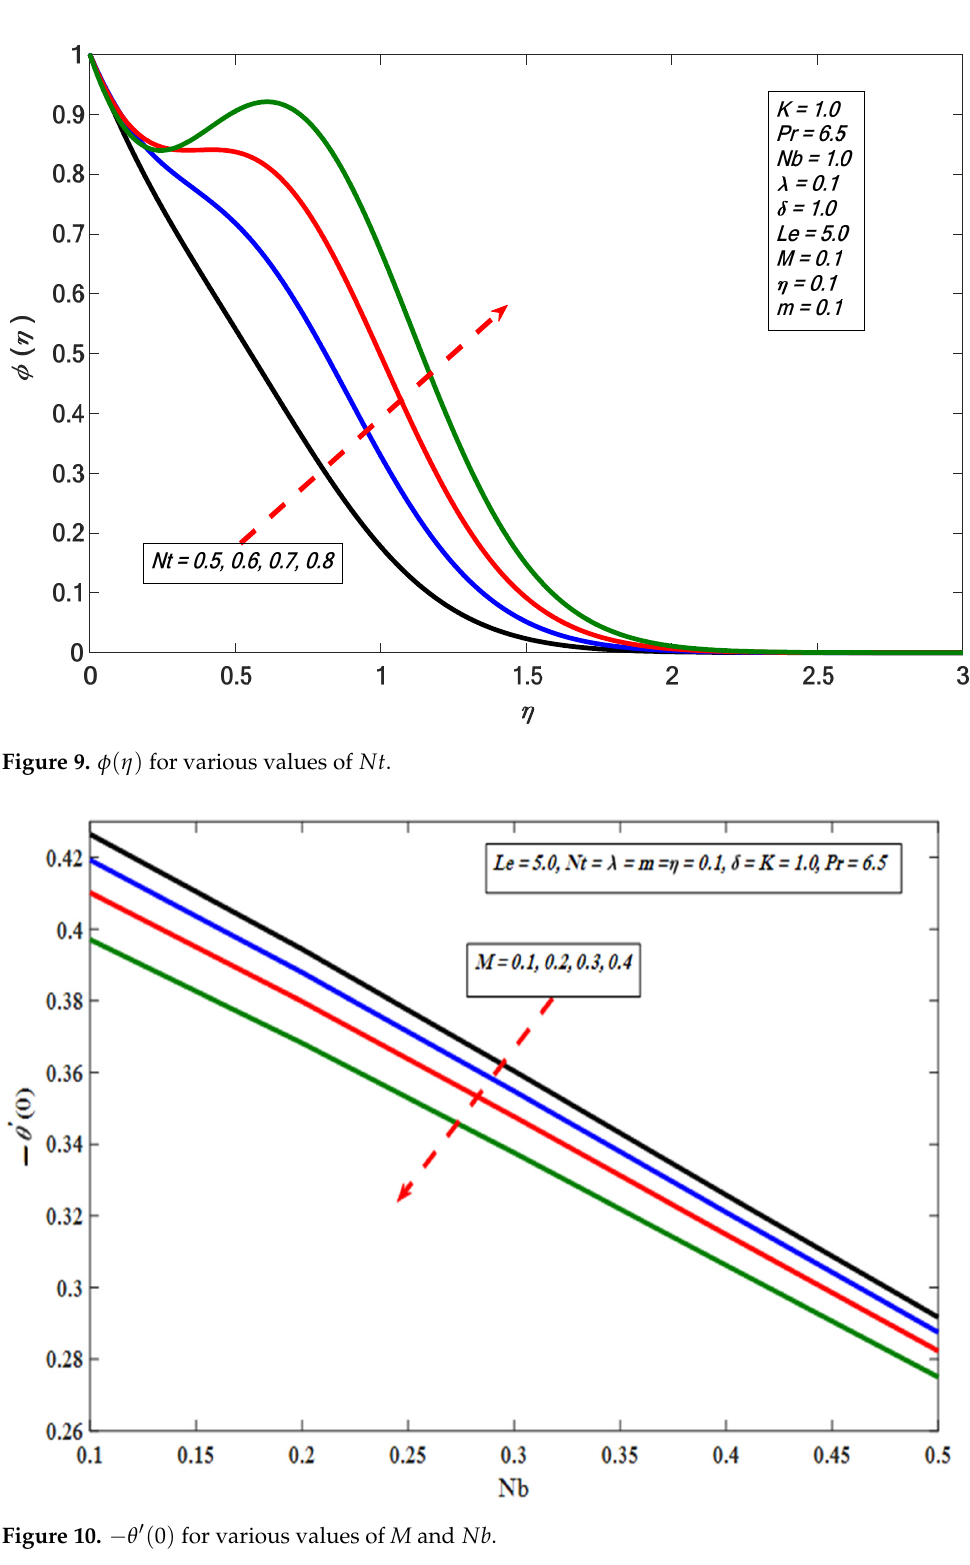
Figure 8. 𝜙(cid:4666)𝜂(cid:4667) for various values of 𝑁𝑏 .